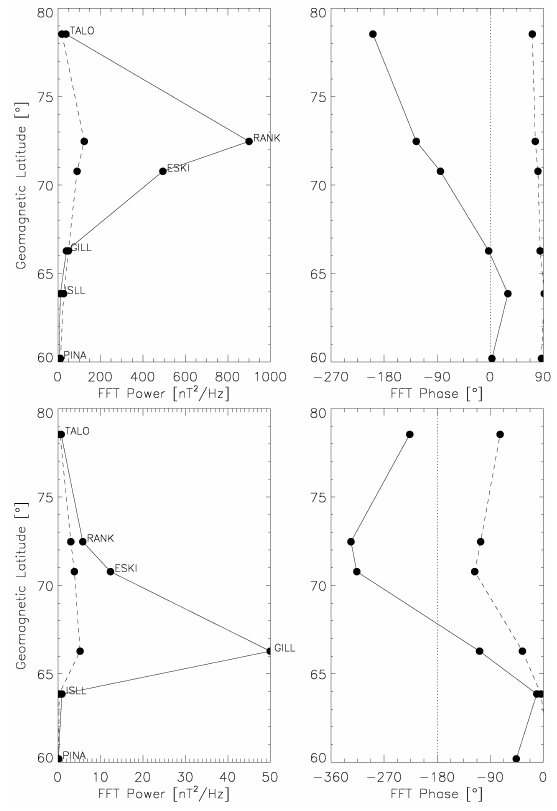
Fig. 9. Latitude profile of Fourier power and phase at 1.2mHz (top panels) and 2.8mHz (bottom panels) for 12 November 2004.